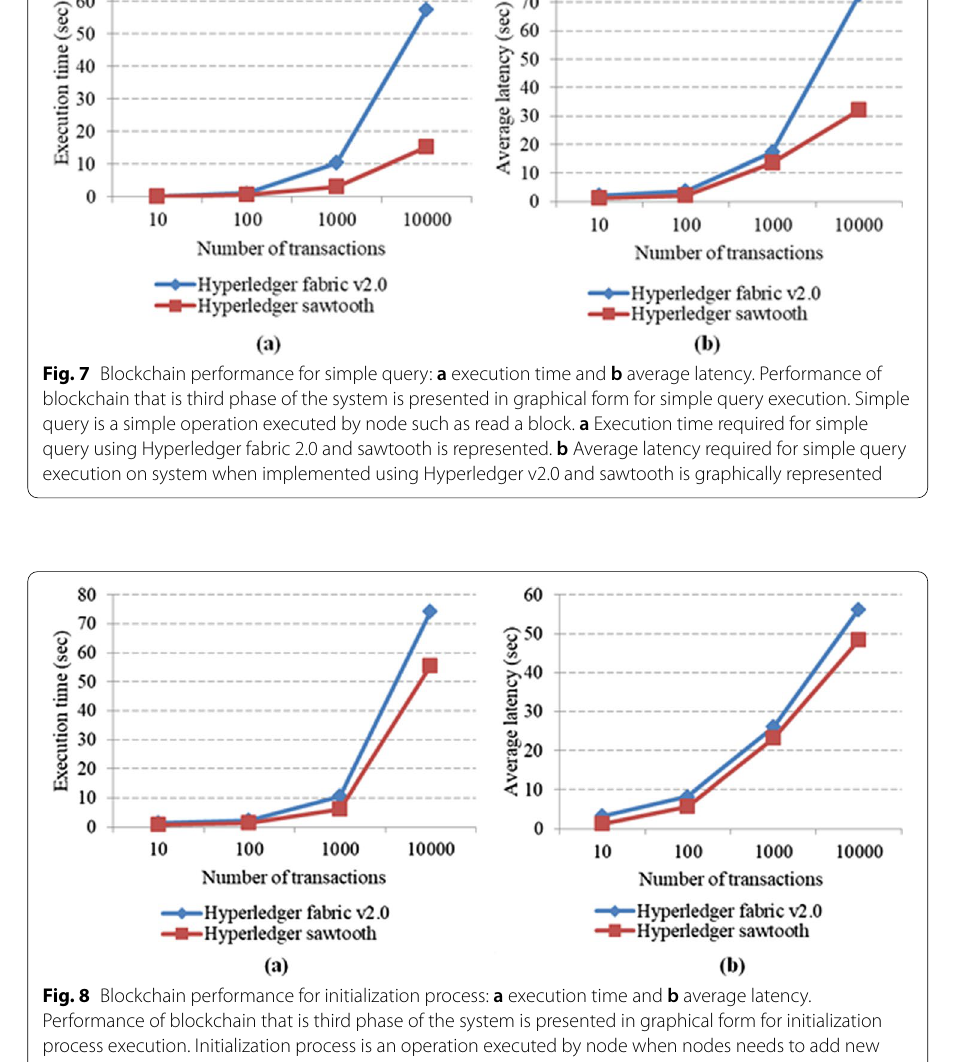
Evaluation of throughput Throughput of the system is the number of transactions exe- cuted by the node per unit time. Average Throughput of a network depends on the number of nodes available in the network. As the number of node initiator and vali- dator increased then the throughput of the system can also get increased. Throughput depends on the number of features such as the block size allowed in the blockchain or the number of nodes in the network. Figure 10a, b demonstrate the throughput of the system with different block size and number of nodes in the network, respectively.